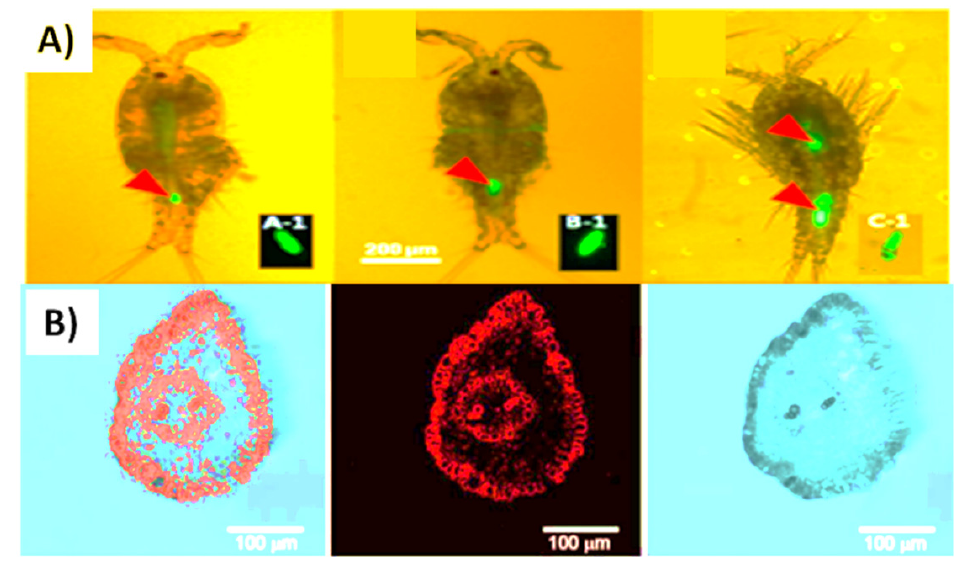
Figure 6. Fluorescently tagged PS beads of ( A ) 50 nm intake by T. japonicas copepod Reproduced with permission from Lee et al. Environmental Science & Technology; published by American Chemical Society, 2013. ( B ) 200 nm uptake by lettuce root and stem [61,62]. Reproduced with permission from Li et al., Chinese Sci. Bull.; published by Elsevier 2019.